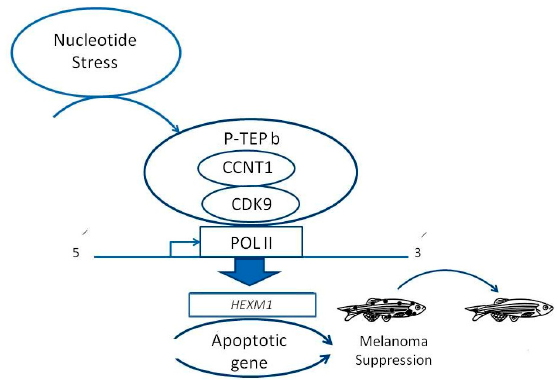
Figure 3. The tumor suppressor hexamethylene bisacetamide inducible 1 ( HEXIM1) gene inhibits melanoma in the zebrafish model. HEXIM1 plays an important role as a melanoma tumor suppressor in response to nucleotide stress. HEXIM1 forms a complex with positive transcription elongation the “anti-cancer” gene expression. Pol II: DNA polymerase II; CDK9: cyclin-dependent kinase; CCNT1: